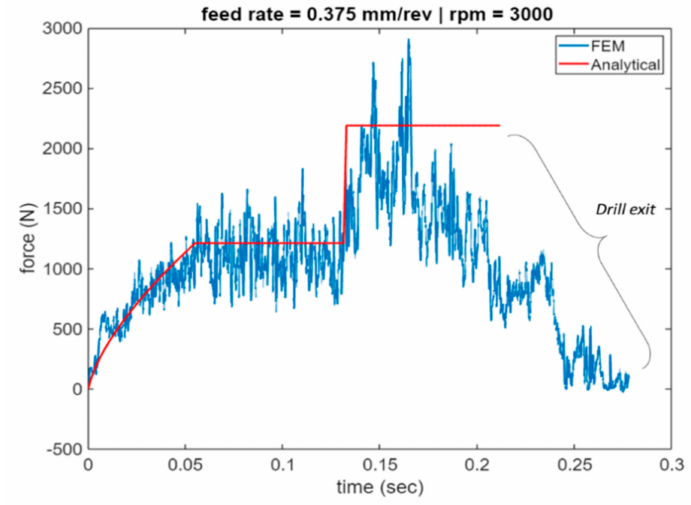
Figure 17. Force profile for scenario 6 of feed rate 0.375 mm/rev and 1000 spindle rpm (Analytical vs.